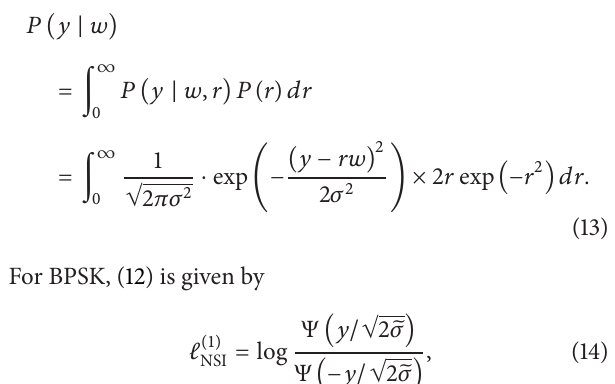
Figure1:SignalconstellationsforBPSKand8-PAMwithGraylabel-